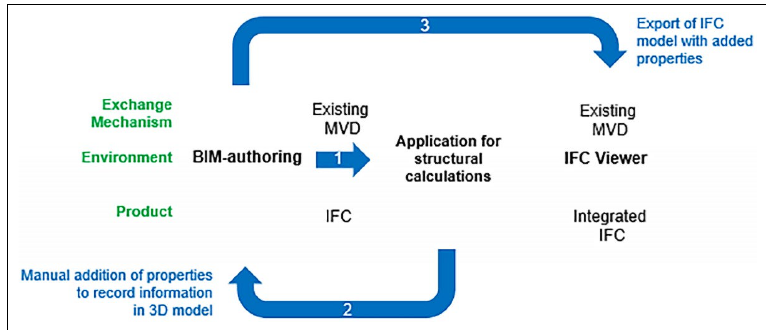
Figure 3. Possible information flow for integrating structural information into an IFC model